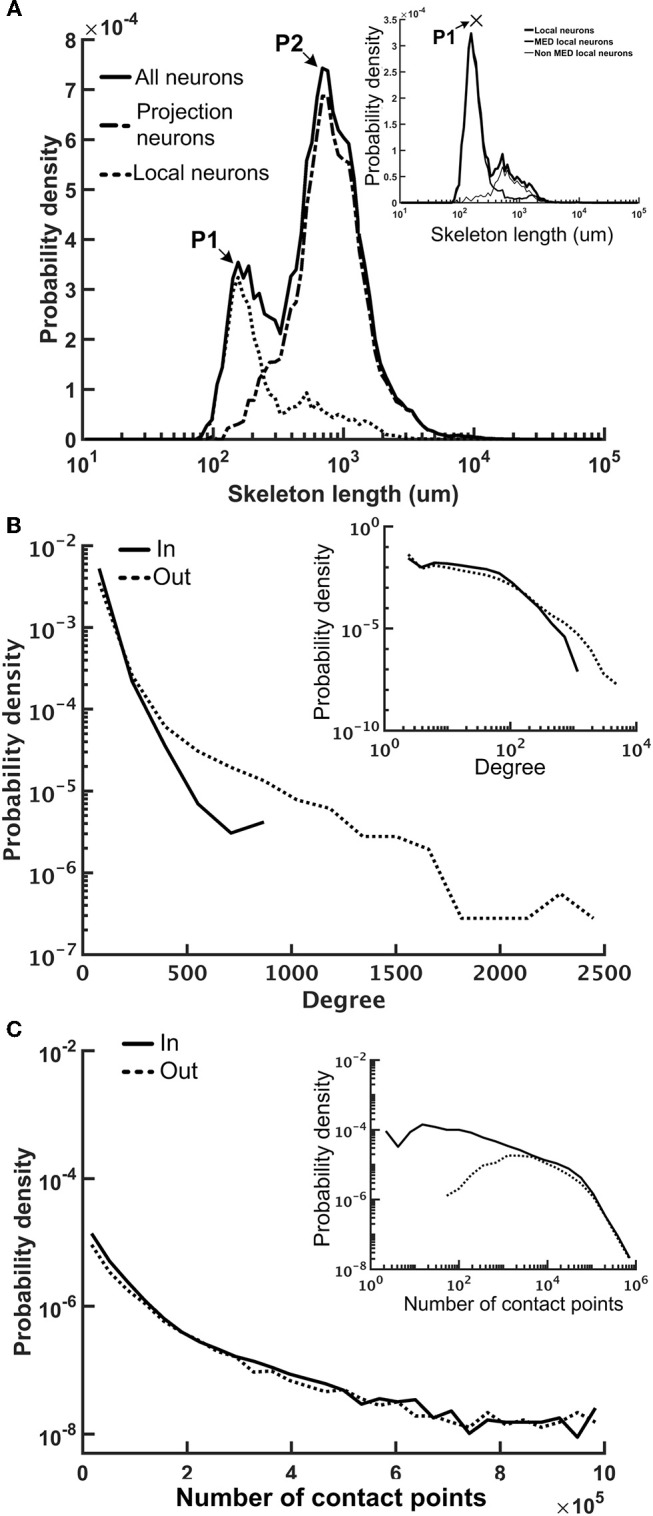
The neuron size and network connectivity of the fruit fly brain network are highly diverse. (A) the distribution of neuron size as represented by the total skeleton length. The probability density was calculated by dividing the number of neurons in each bin by the total number of neurons and by the bin size. The sizes for all neurons (thick black) exhibit a bi-modal distribution. The left peak is mainly contributed by the local neurons (dotted curve), while the right peak is mainly contributed by the projection neurons (dashed curve). The distribution of the local neurons also forms two peaks with the shorter-length peak contributed by medulla (MED) local neurons and the longer-length peak, by non-MED local neurons (inset). (B) The distribution of degree (number of connections of each neuron) follows a broad distribution for both in-degree (input connections) and out-degree (output connections). Inset: a double-log plot of the same curves. (C) The distribution of the contact point number of each neuron also exhibits a long tail distribution for both input and output contact points. Inset: the same curves in a double-log plot.